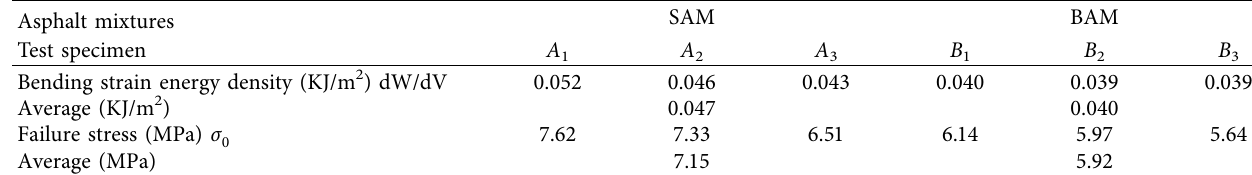
Table 6: Bending strain energy density (dW/dV) of SAM and BAM.